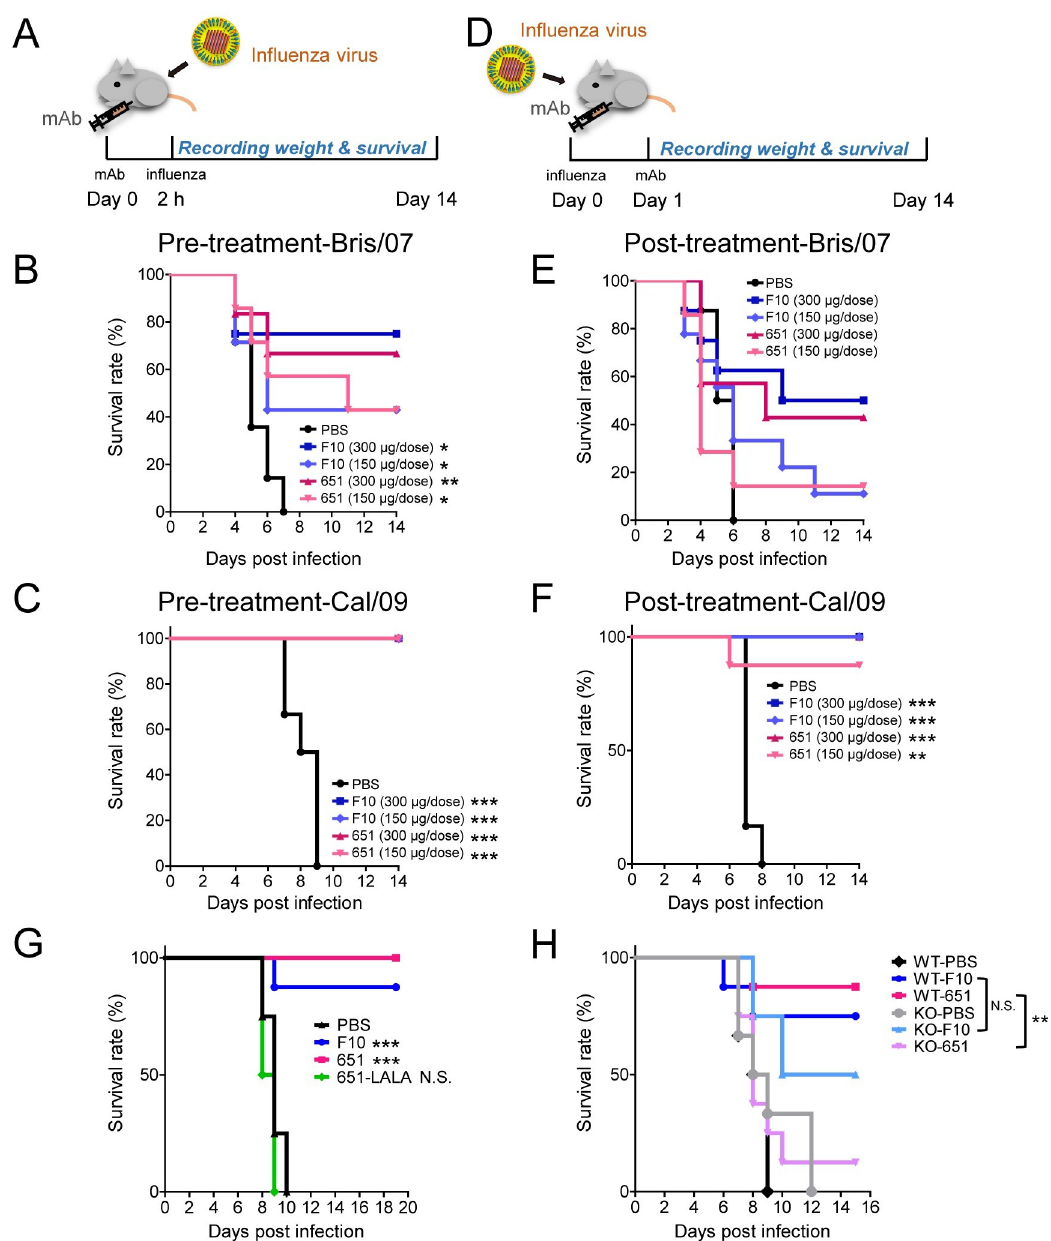
Fig 2. Prophylactic and therapeutic efficacy of 651 in mice challenged with lethal dose of H1N1. (A-C) Cumulative survival rate of mice treated (i.p.) with indicated mAb 2 h before challenge with 100 LD50 of H1N1 Bris/07 virus (B) or Cal/09 virus (C). n = 4–14 mice per group in B and 6–8 mice per group in C. (D-F) Cumulative survival rate of mice injected (i.p.) with 651 24 h after challenge with 100 LD50 of H1N1 Bris/07 virus (E) or Cal/09 virus (F). n = 7–9 mice per group in E and 6–8 mice per group in F. (G) Cumulative survival rate of mice treated with F10, 651, or a mutation of 651 (651-LALA) after challenge with Cal/09 at 100 LD50. n = 8 mice per group. (H) Cumulative survival rate of Fc γ R knockout (KO) mice and control WT mice after F10 or 651 pretreatment and Cal/09 virus challenge. n = 6–8 mice per group. Data were analyzed by log-rank (Mantel-Cox) test. The statistical significance was calculated for the differences between PBS control and mAb treated groups (in B, C, E, F, and G), or between WT and Fc γ R knockout (KO) mice receiving the same kind of mAb (in H). � p < 0.05; �� p < 0.01; ��� p < 0.001. N.S. = no significant difference.